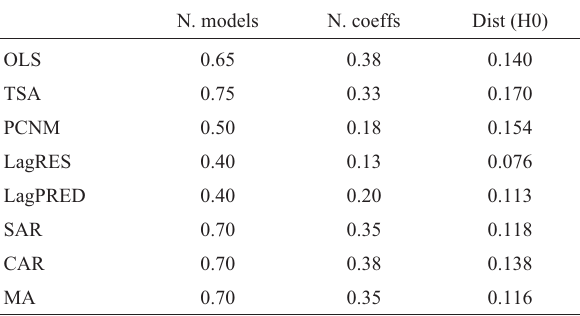
Table 1 - A comparison of spatial regression methods based on the analy- sis of null expectation, by regressing allele frequencies evolving under a pure isolation-by-distance process against three explanatory variables (factors). N. models refers to the frequency (out of 20 simulations) with at least one significant (p < 0.05) regression slope, whereas N. coeff. shows the frequency (out of 60 coefficients) of significant coefficients. The Dist(H0) refers to the average Euclidian distances between the regression coefficient vector (cid:5) and the null expectation (all slopes are zero).